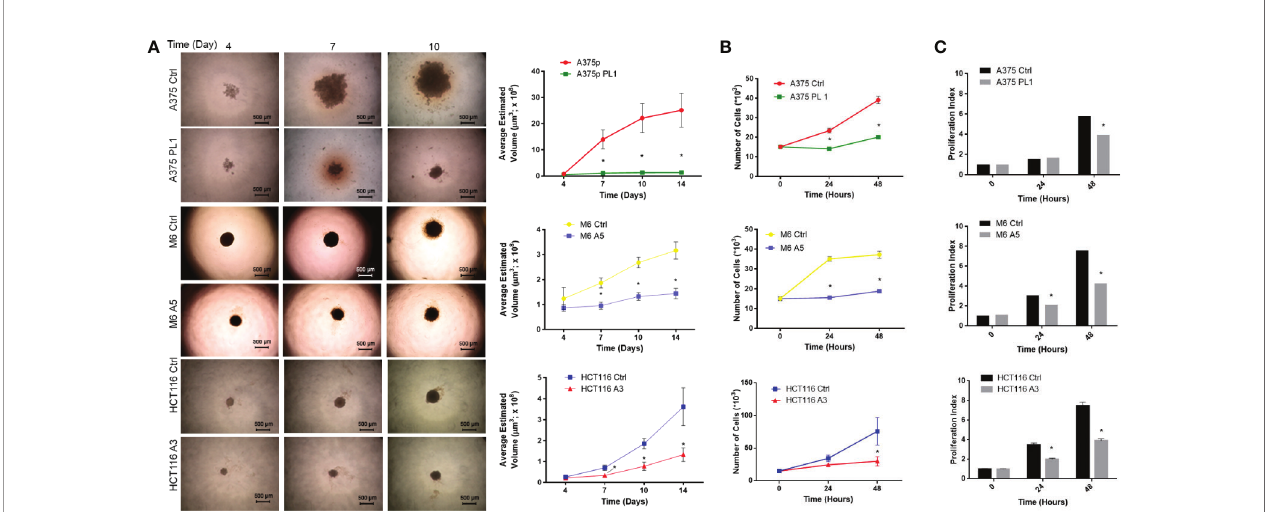
FIGURE 1 | (A) Agar-coated 96-well fl at-bottomed plates were used to generate spheroids (a single spheroid per well). Starting from day 4 post generation, images were obtained at intervals using an inverted microscope. The analysis was carried out using ImageJ software and growth curves were obtained (n = 60 spheroids/